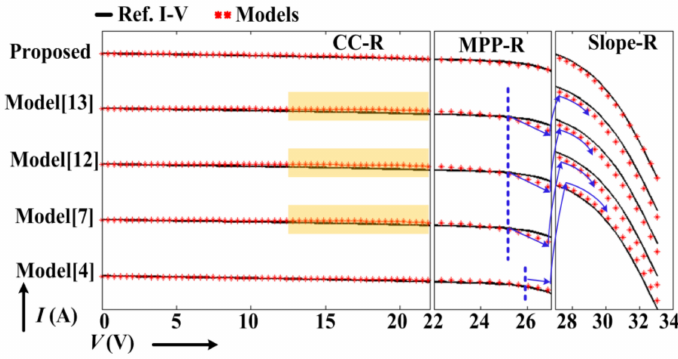
Figure 8. Resemblance between original I-V curve under STC versus different models’ curves.